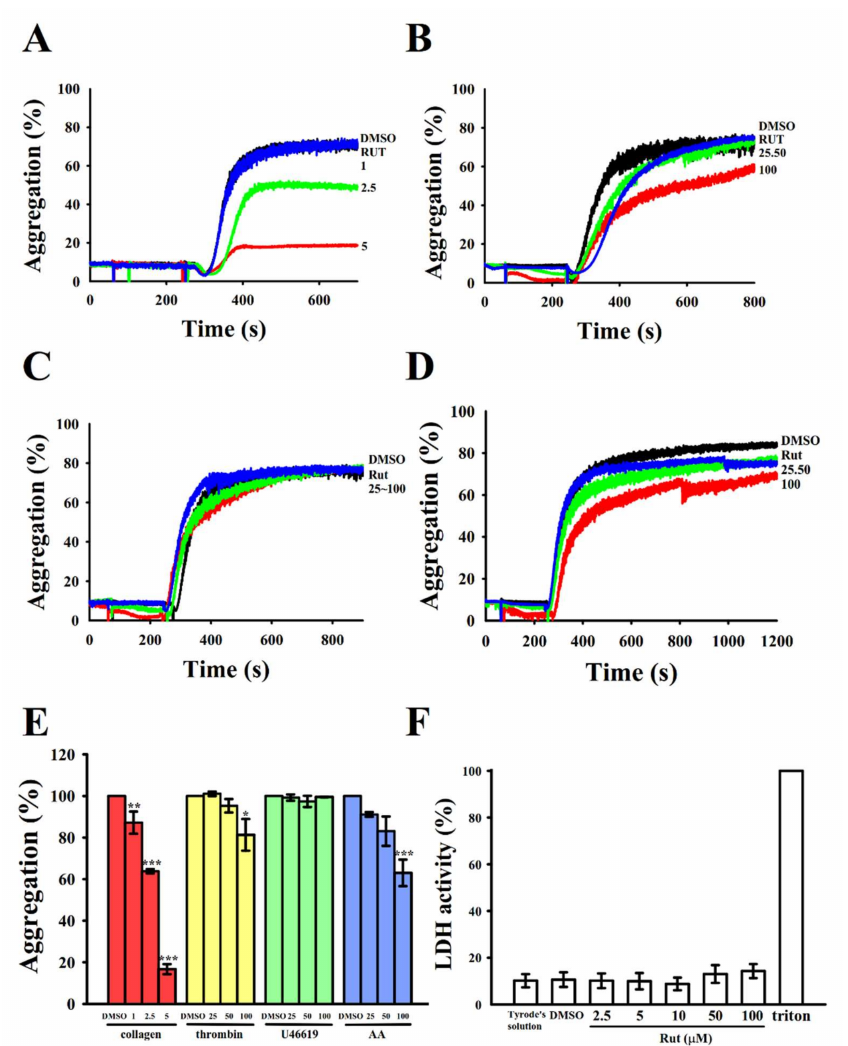
Figure 1. Inhibitory activities of rutaecarpine (Rut) on platelet aggregation and the cytotoxic test in human platelets stimulated with various agonists. Washed human platelets (3.6 × 10 8 cells/mL) were preincubated with a solvent control (0.1% DMSO) or Rut (1–100 µ M) and subsequently treated with collagen ( A ; 1 µ g/mL), thrombin ( B ; 0.02 U/mL), U46619 ( C ; 1 µ M), or arachidonic acid (AA) ( D ; 60 µ M) to stimulate platelet aggregation. ( E ) Concentration–response histograms of Rut representing its inhibitory effects on platelet aggregation stimulated by various agonists (%). ( F ) To evaluate cytotoxicity, platelets were pretreated with solvent control (0.1% DMSO) or Rut (2.5,5, 10, 50, and 100 µ M) for 20 min, and 10 µ L of the supernatant was dropped on a Fuji Dri-Chem slide LDH-PIII. * p < 0.05, ** p < 0.01, and *** p < 0.001 compared with the 0.1% DMSO-treated group. Data ( E , F ) are presented as the mean ± standard error of the mean ( n =